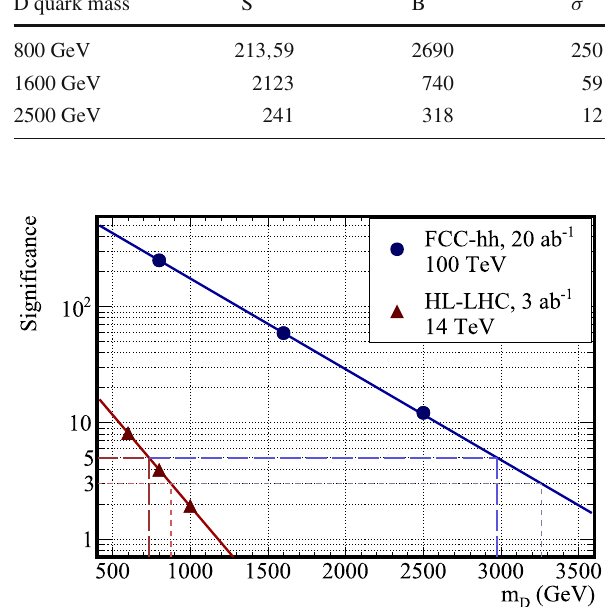
Fig. 9 Signal significance as a function of D quark mass for HL-LHC and FCC-hh